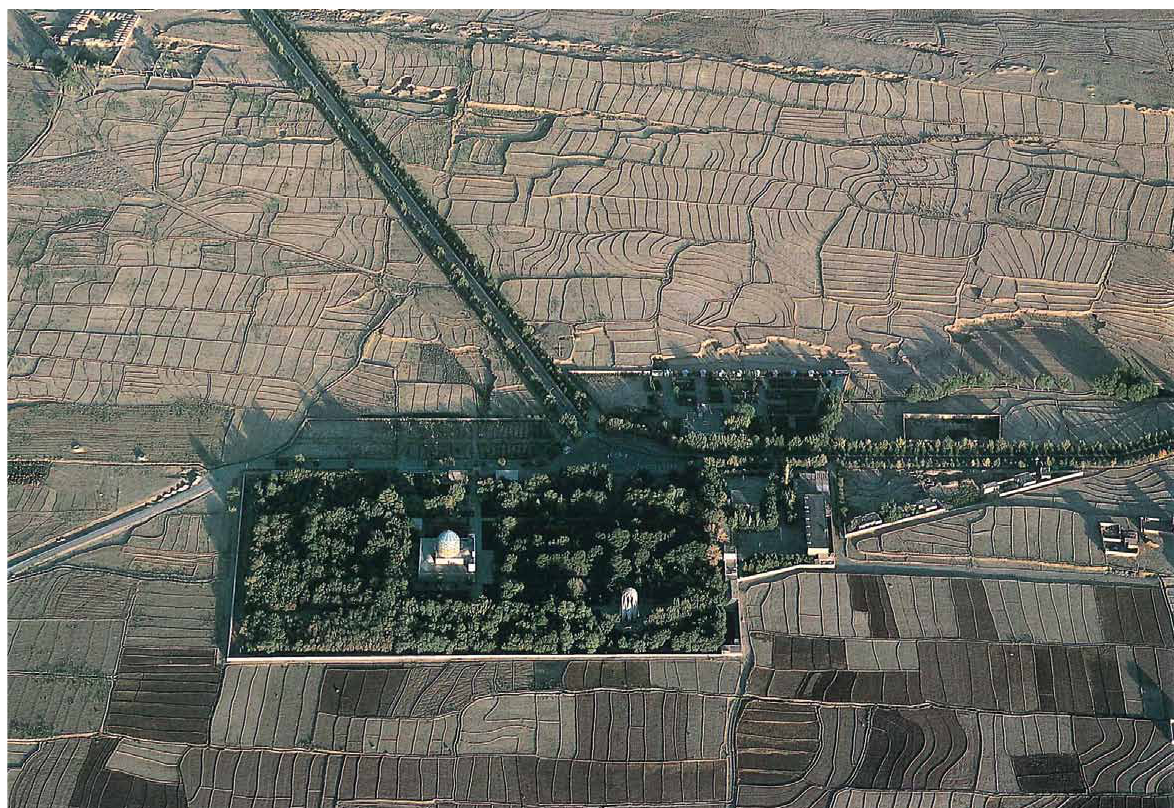
fig. 1. Iranian Bāgh (garden). The burial place of omar Khayyam at nishapur. Source : Mousavi, a; Stronach, D. 2012. ancient Iran from the air. Mainz: Verlag Philipp von